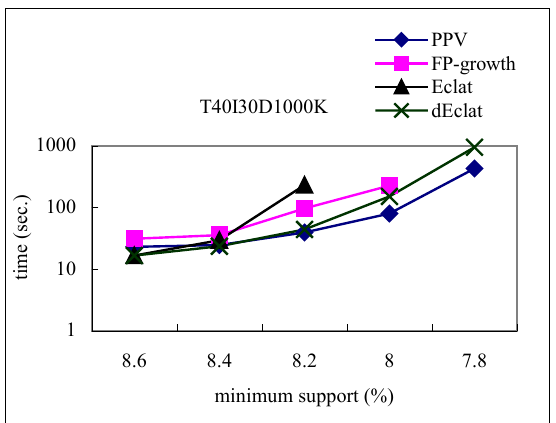
Fig. 10. Average Length of Node-lists, tid-lists, and diffsets Cardinality on